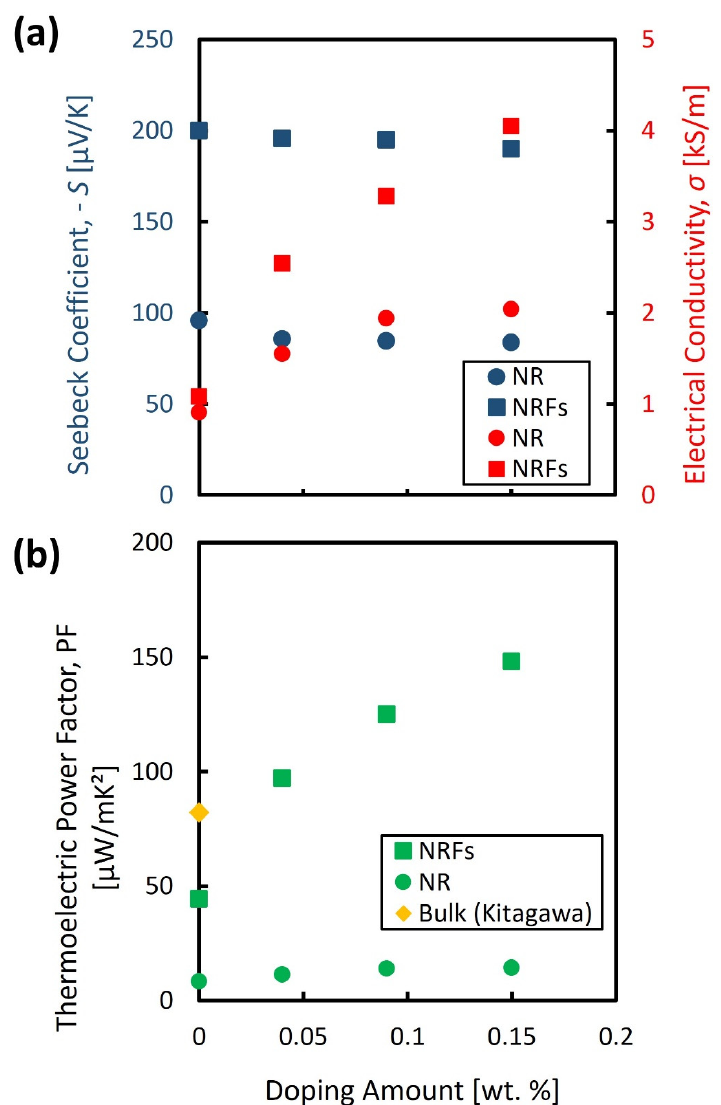
Figure 2. Evaluated ( a ) S and σ , and ( b ) PF, as a function of wt.% of AgNO 3 . The filled circle • and square ■ represent the evaluated value for NR and NRFs samples, respectively. The filled blue and red points represent the S and σ , respectively. The filled diamond ♦ represents the reported value for bulk TiO 2 which is adapted from [9].